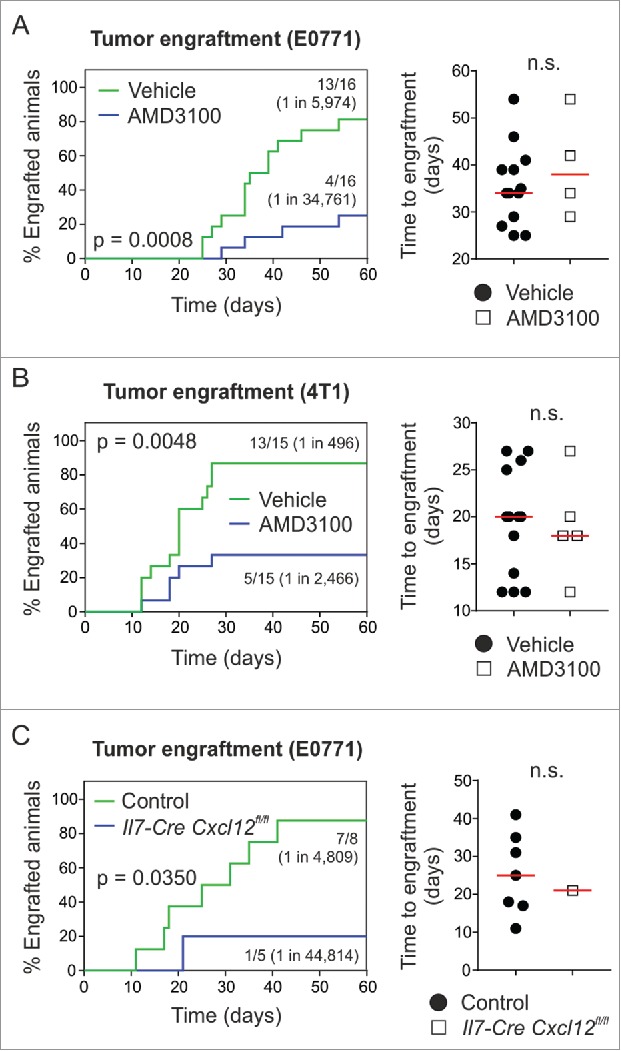
Pharmacological targeting of CXCR4 or conditional ablation of Cxcl12 depletes breast tumor-initiating potential. (A) 104 E0771 or (B) 103 4T1 cells were orthotopically grafted in syngeneic wild-type hosts (i.e., C57BL/6 or BALB/c) and animals were treated systemically (i.p.) with 5 mg/kg AMD3100 or vehicle (PBS) on days 0 and 3 post tumor challenge, respectively (n = 15–16). Tumor outgrowth and time to engraftment were monitored. (C) 104 E0771 cells were orthotopically grafted in Il7-Cre Cxcl12fl/fl hosts and Cre-negative controls (carrying homozygous Cxcl12fl/fl alleles), and tumor outgrowth and time to engraftment were monitored (n = 5–8). Statistical testing used: Log-rank test for Kaplan-Meier curves, and Mann-Whitney U test for the remaining panels.